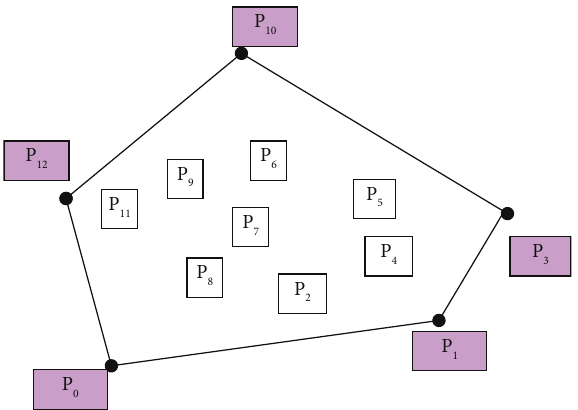
Figure 4: Definition of convex